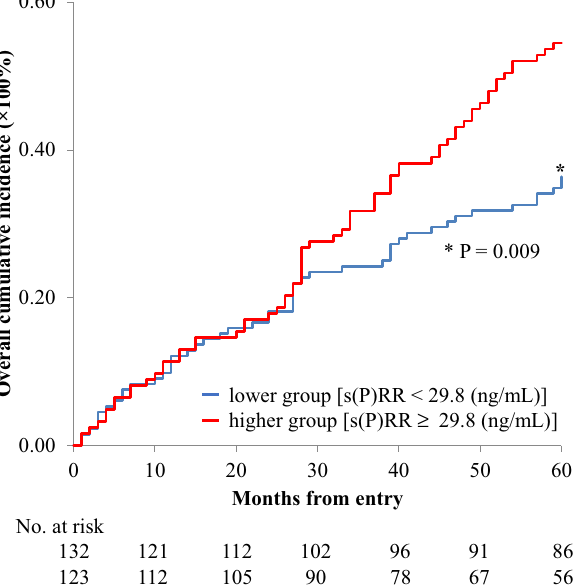
Figure 1. Cumulative probability of cardiovascular events. Kaplan–Meier plots comparing patients with higher and lower serum concentrations of s(P)RR. s(P)RR, soluble (pro)renin receptor.